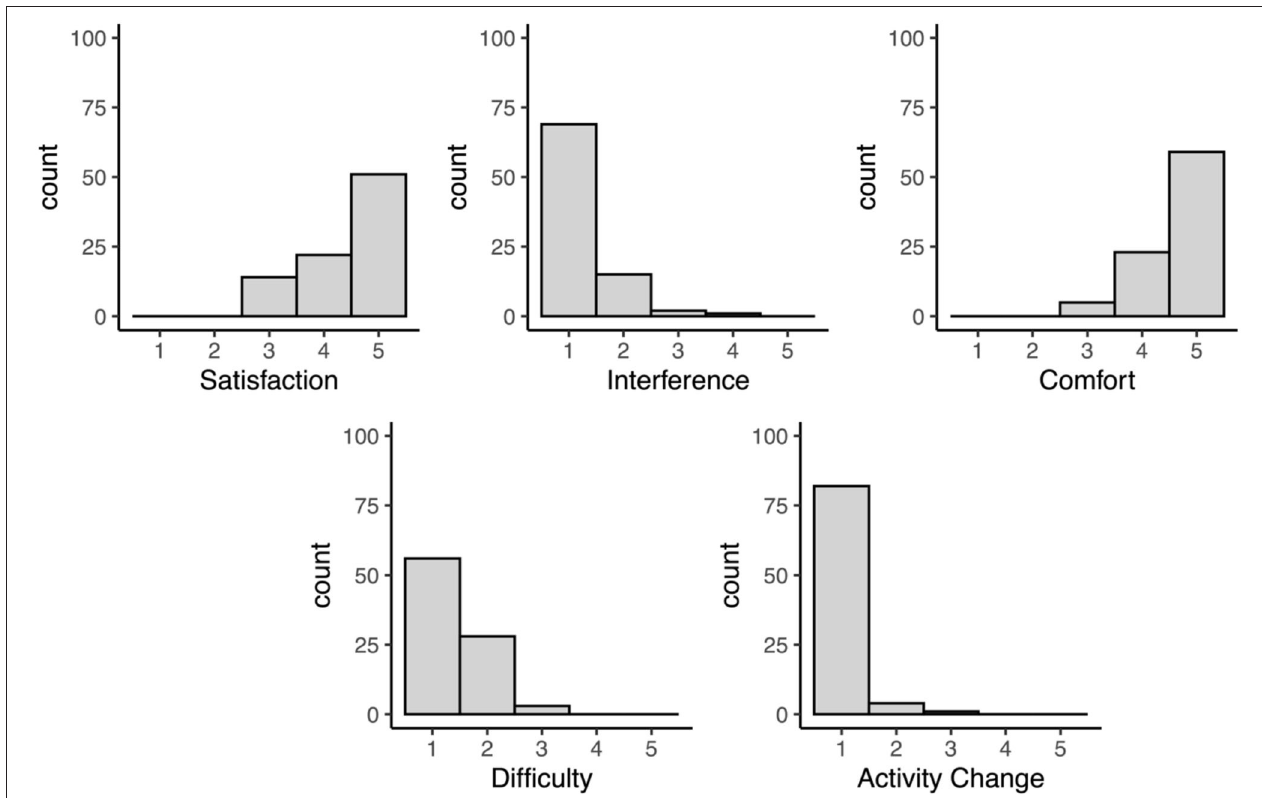
FIGURE 2 | Distributions of responses to the study feedback questionnaire. All items are rated on a scale from 1 (not at all) to 5 (very